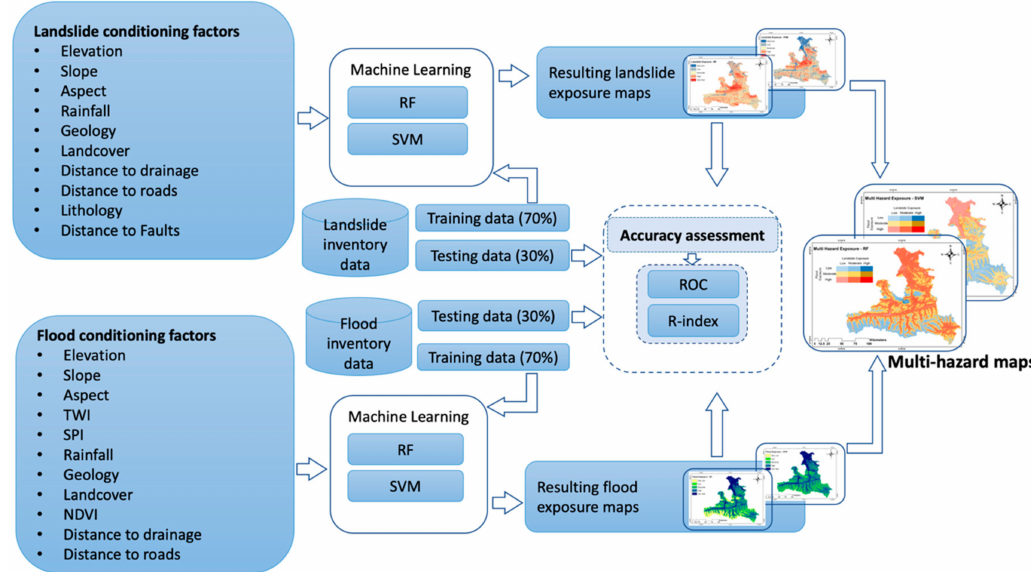
Figure 4. The methodological workflow used for the multi-hazard exposure mapping for the State of